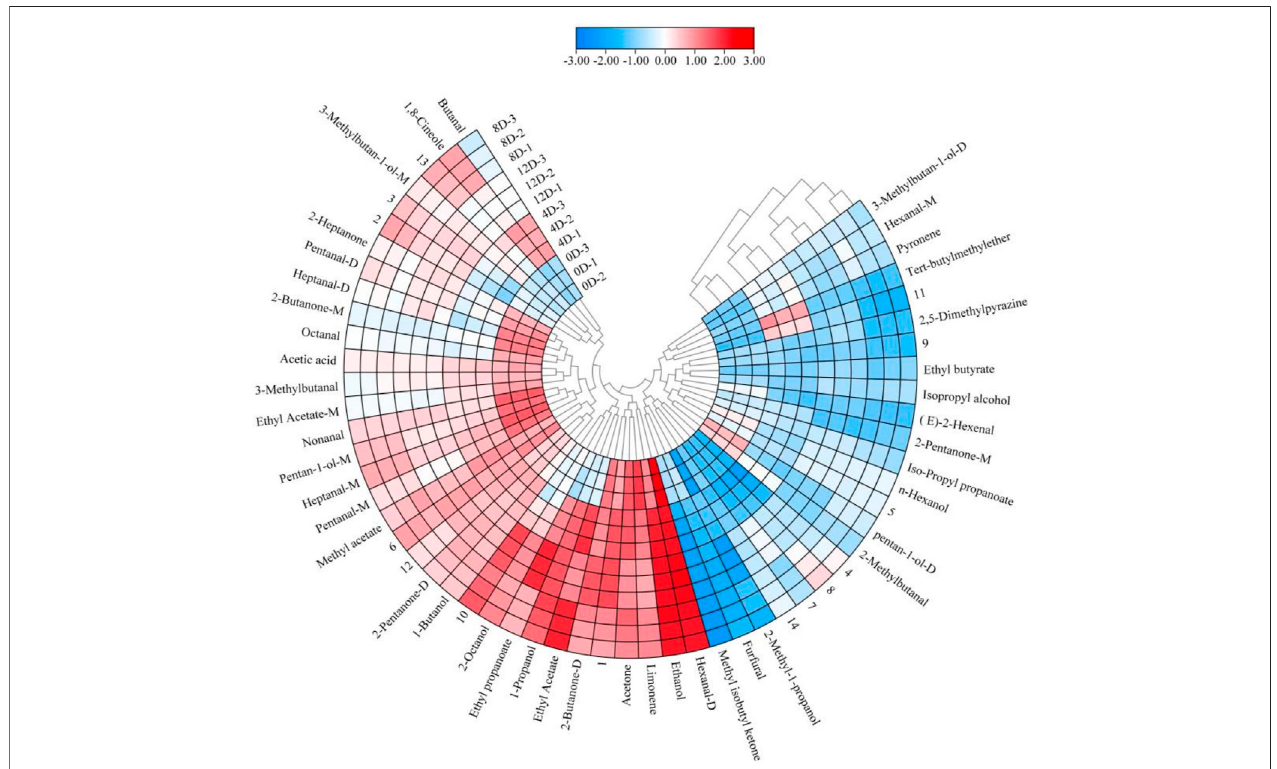
FIGURE 4 | Heat map and hierarchal clustering of the volatile pro fi les of fermented mandarin fi sh samples. Values are obtained from three biological replicates.